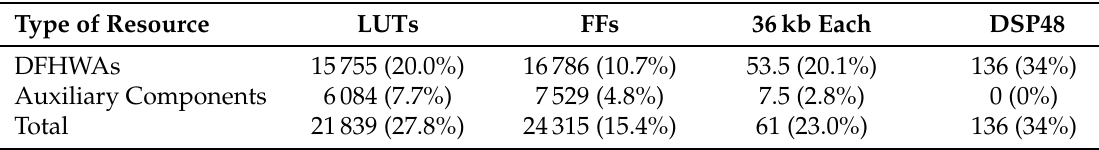
Table 5. Resource utilization for the complete